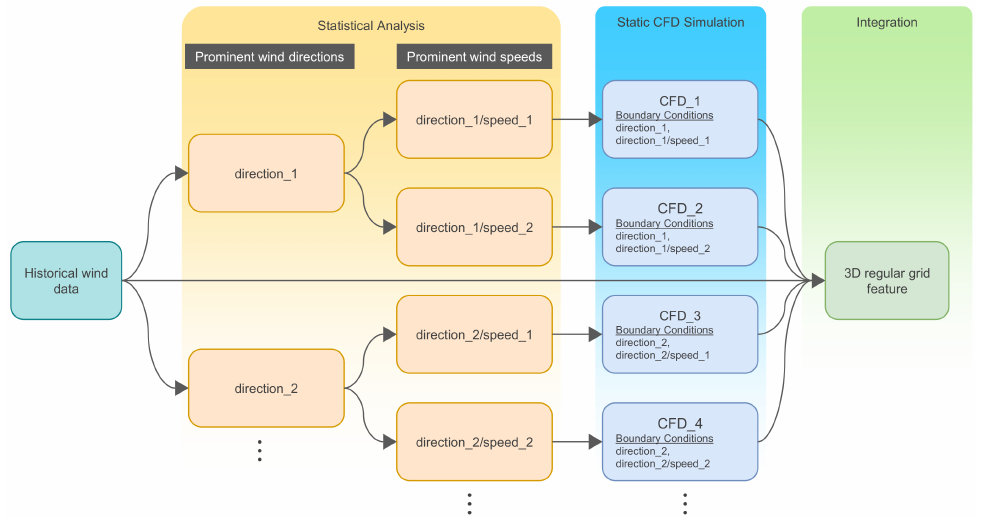
Figure 3. Conceptual graph of the